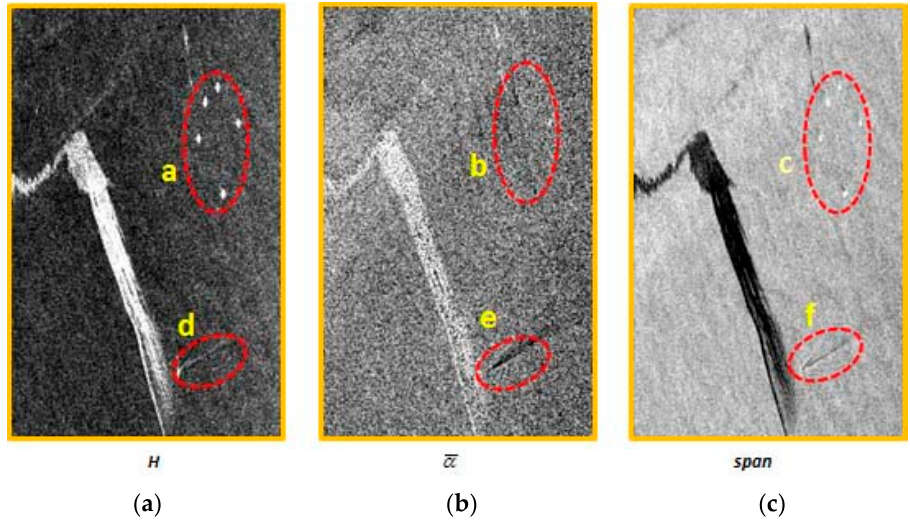
Figure 6. The difference of identifying ability of oil spill from the boat wake and drilling platforms based on several fully Pol-SAR features extracted from Dataset 1. ( a ) the image of fully Pol-SAR feature H (polarization entropy); ( b ) the image of fully Pol-SAR feature α (mean scattering angle); ( c ) is the image of fully Pol-SAR feature span (backscattered energy)